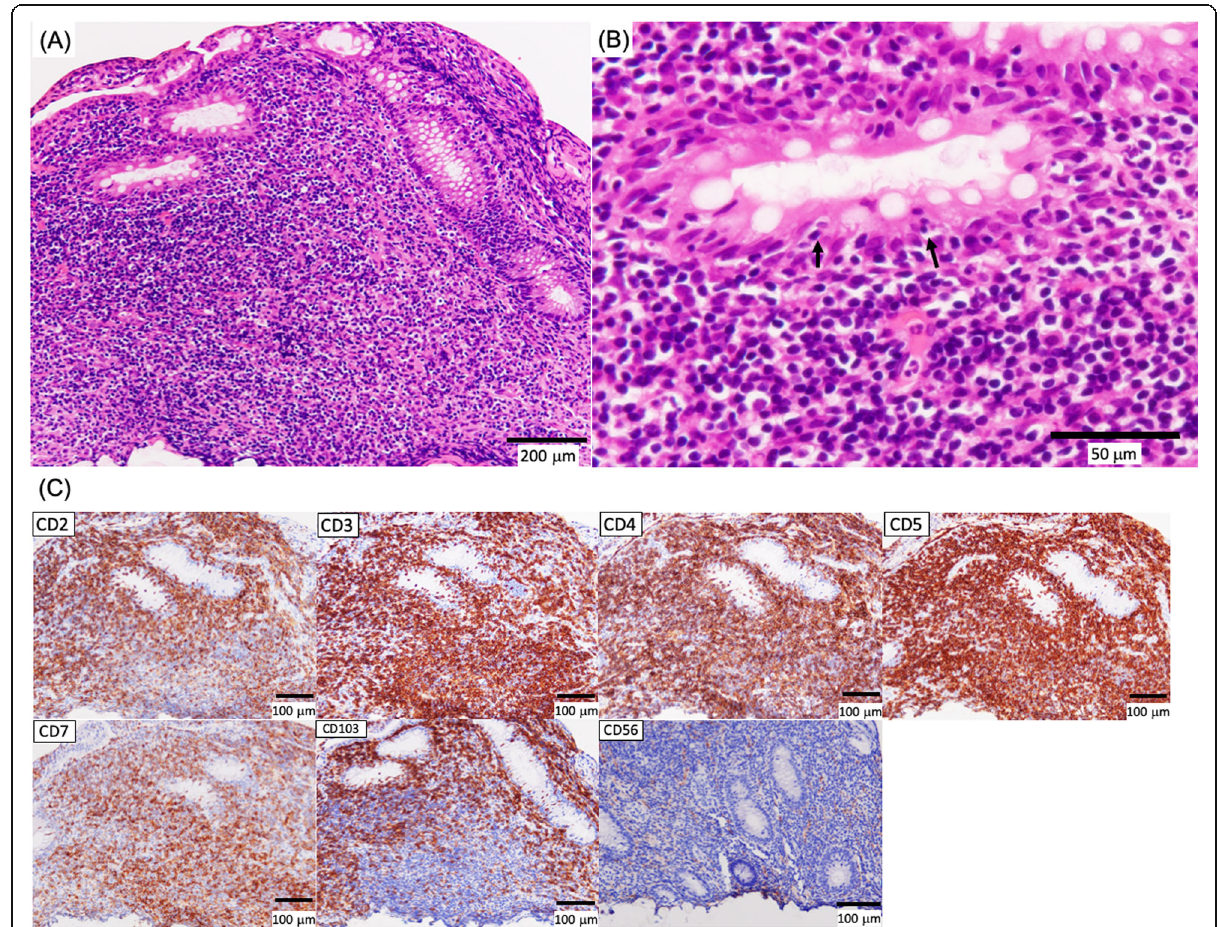
Fig. 4 Histopathological examination in the tissue biopsy of the GI tract. a , b Ulceration in the ileum. a The lesion surrounded by a dense lymphocyte infiltration around the crypts. b Most infiltrating lymphocytes were small to medium size without significant nuclear atypia. Cryptitis was found in areas as shown by the arrows. c Immunohistochemically, the lymphocytes express CD2, CD3, CD4, CD5, CD7, and CD103 and lack CD56